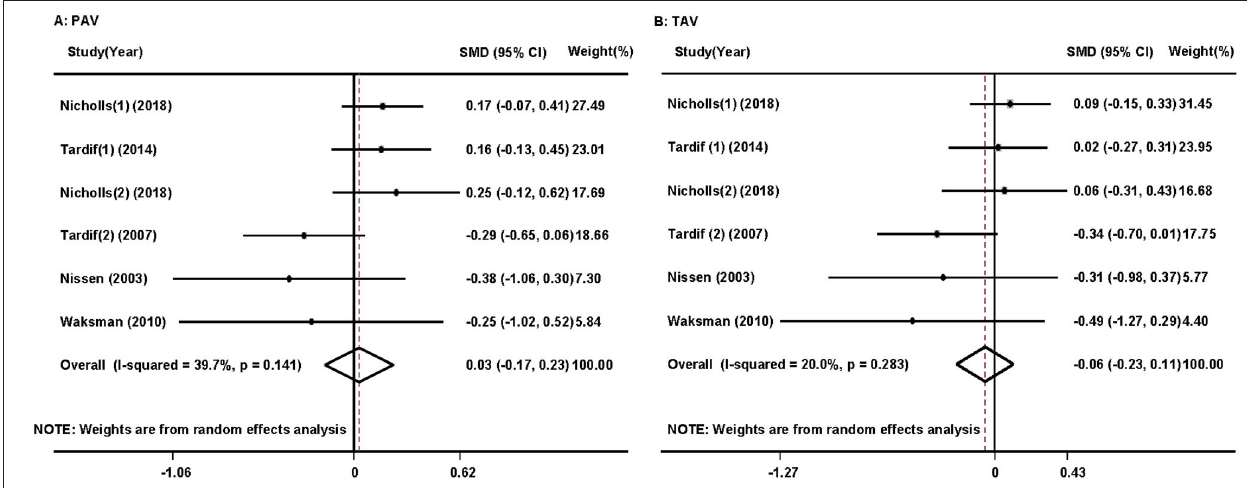
FIGURE 2 | Forest plots of the meta-analysis of the associations between percent atheroma volume (PAV) (A) and total atheroma volume (TAV) (B) in the coronary artery and high-density lipoprotein/apolipoprotein A1 (HDL/apoA-1) replacement therapy administration in acute coronary syndrome patients using a random-effects model. SMD, standardized mean difference; CI, confidence interval. This result shows that HDL/apoA-1 replacement therapies did not significantly decrease PAV or TAV in patients with acute coronary syndrome.